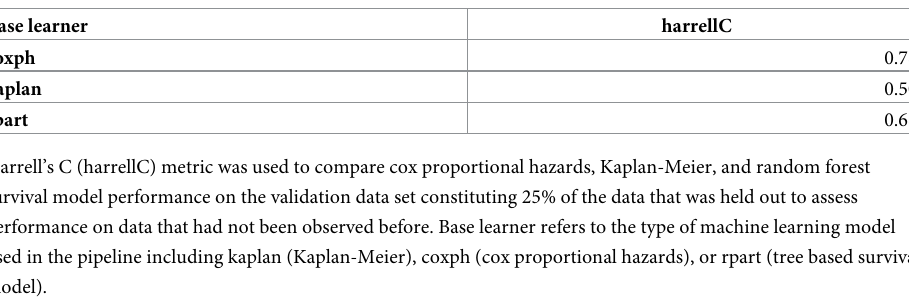
Table 6. Comparison of survival model performance on validation data.